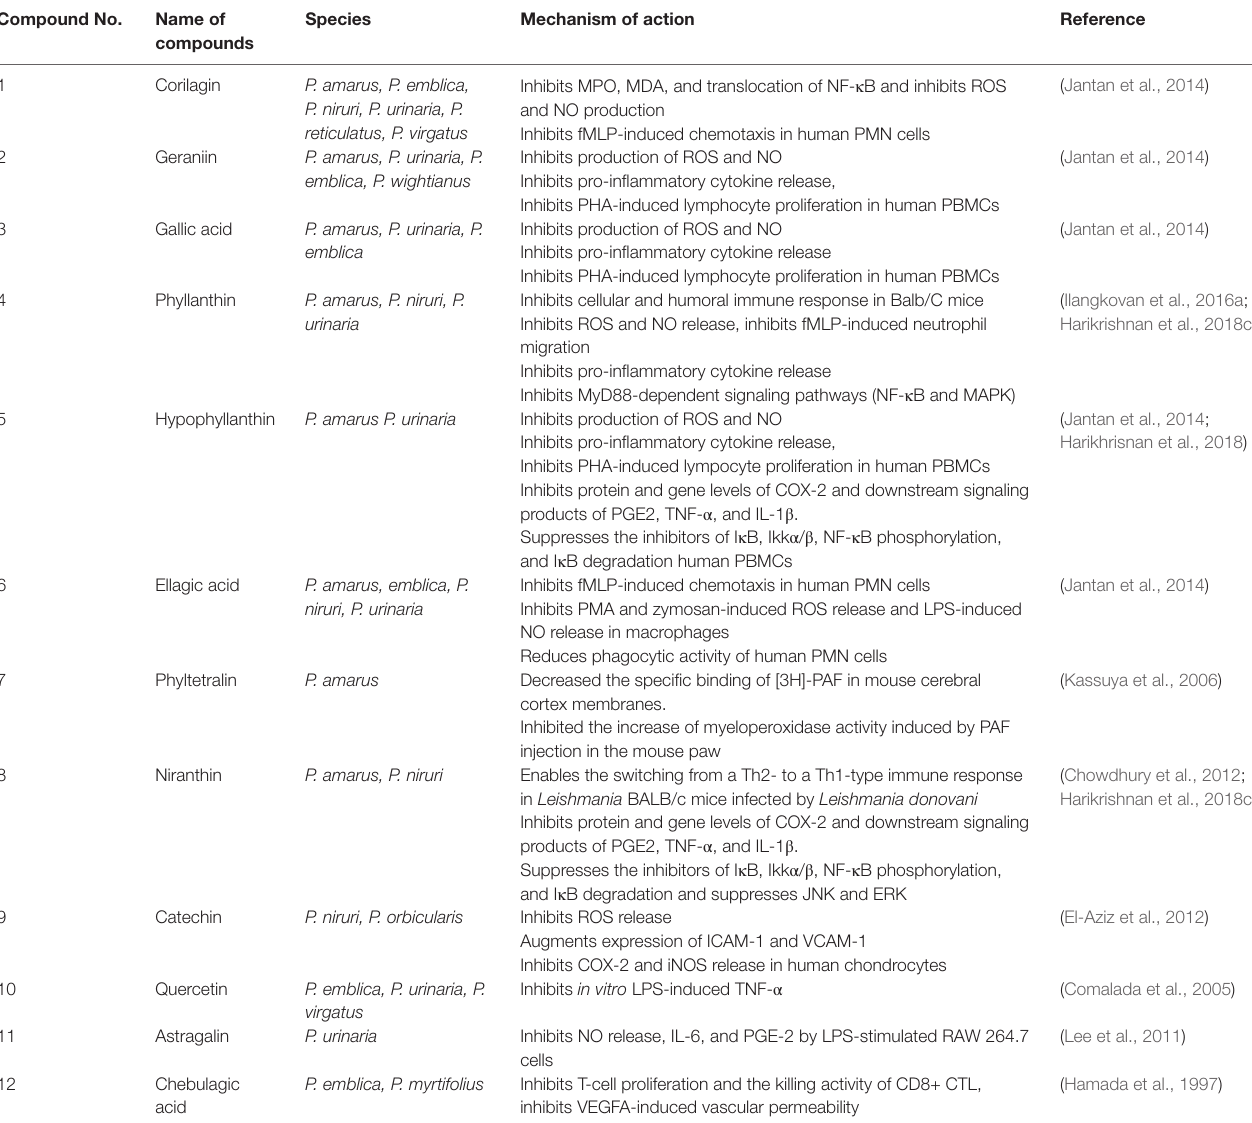
TABLE 2 | The mechanisms of immunomodulatory effects of several bioactive metabolites present in Phyllanthus species. Compound